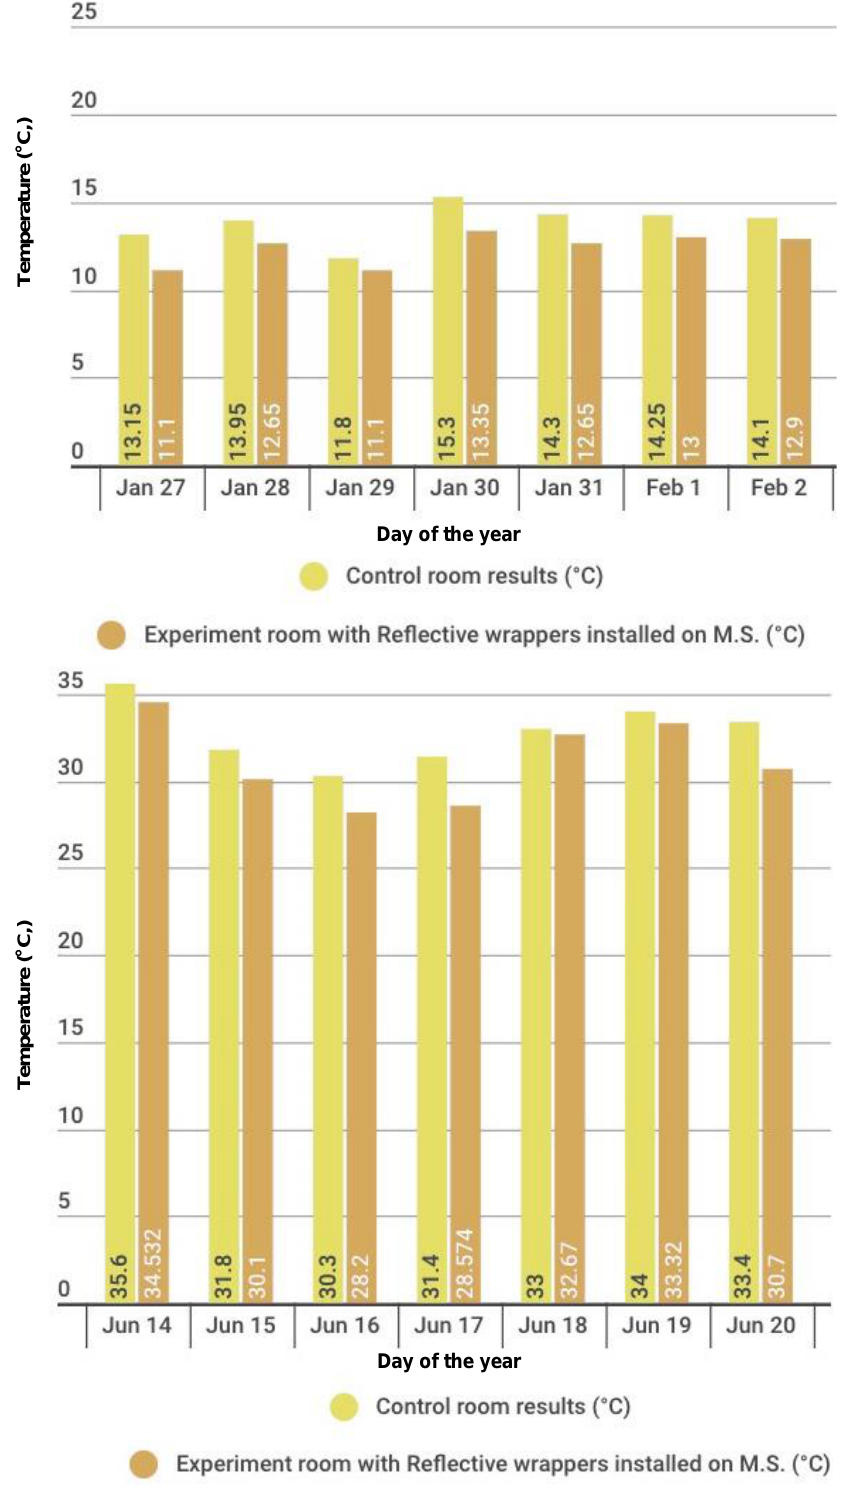
Figure 12. The figure represents the temperature outcomes in both the control room and experiment rooms in both the winter and summer after the installation of the reflective